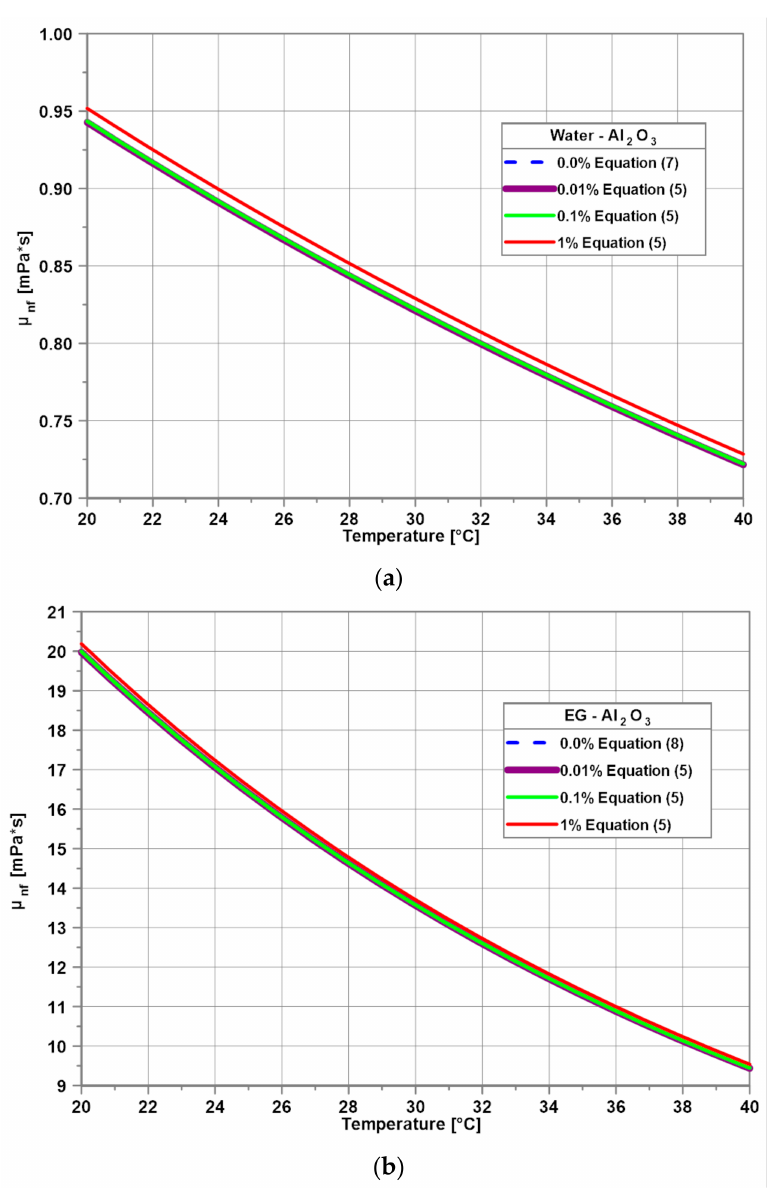
Figure 1. Viscosity of the water-based ( a ) and EG-based ( b )